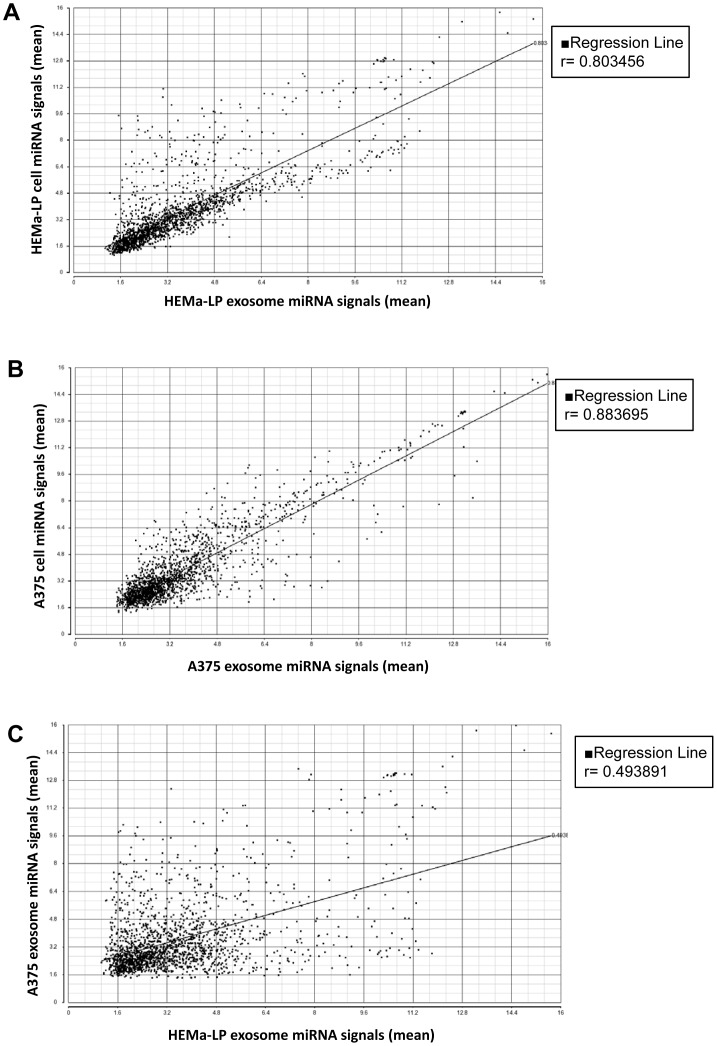
Correlation of miRNA signals between cells and exosomes.Affymetrix miRNA 1.0 arrays were used to analyze miRNA signals in HEMa-LP melanocytes and A375 melanoma cells, as well as exosomes from the two cell lines. Two different arrays were performed from two different RNA preparations for each sample, except for only one RNA preparation for HEMa-LP exosomal miRNA array. Scatterplots of miRNA signals in HEMa-LP exosomes compared with their originating cells (A), A375 exosomes compared with their originating cells (B), and A375 exosomes compared with HEMa-LP exosomes (C). Regression analysis showed that miRNA signals in HEMa-LP cells versus HEMa-LP exosomes, and A375 cells versus A375 exosomes were correlated, whereas miRNA signals in A375 exosomes versus HEMa-LP exosomes were not well correlated.